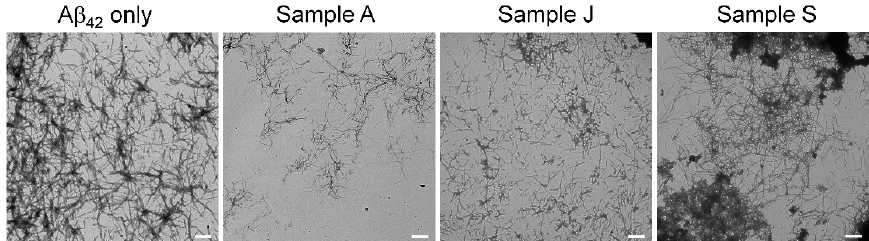
Figure 4. Electron microscopy images of A β 42 aggregates. The A β 42 solution was mixed with each